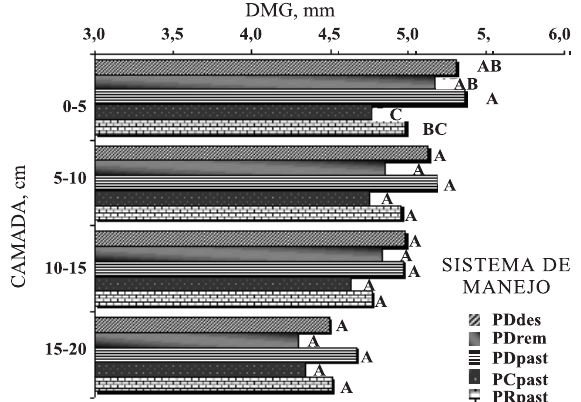
Figura 3. Diâmetro médio geométrico (DMG) dos agregados do solo nos sistemas de manejo e camadas, na integração agricultura-pecuária. Média das três épocas: 16, 88 e 190 DAS. Otacílio Costa - SC, 2003/2004. As médias dos sistemas de manejo em cada camada seguidas por letras iguais não diferem a 5 % pelo teste de